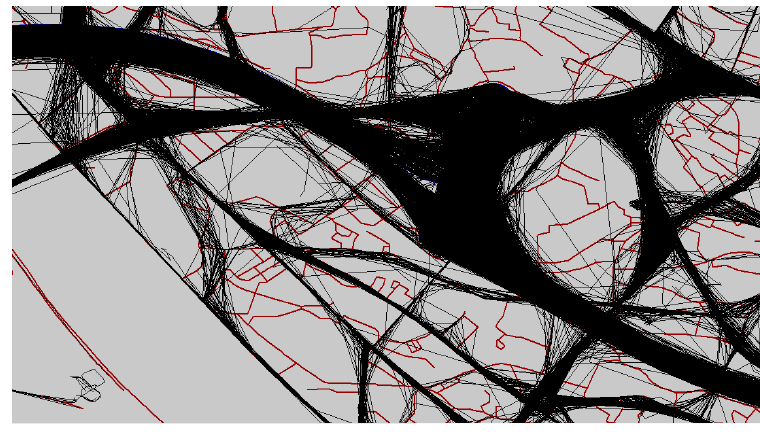
Figure 6. Vehicle tracks.